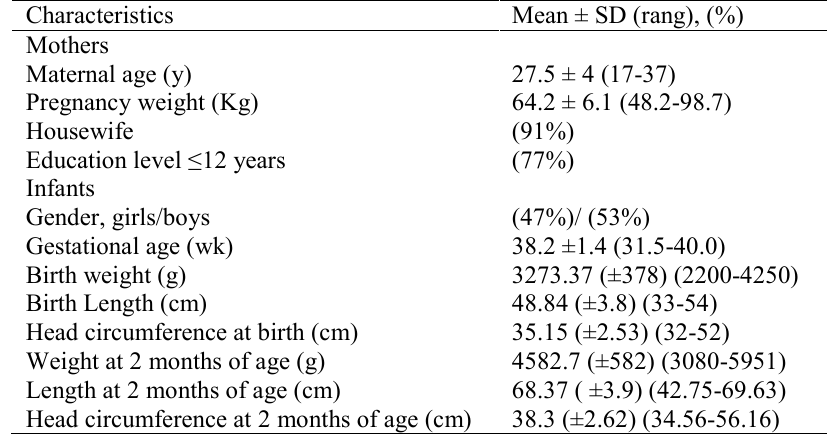
Table 1. Characteristics of the study population